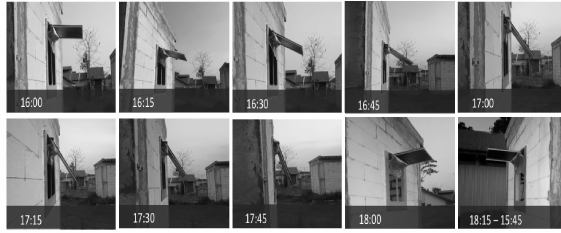
Fig. 6. Movement of shading-pane every 15 minutes recorded during field